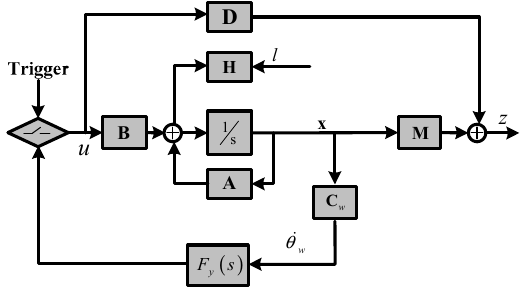
Figure A5. Diagram of the control system.